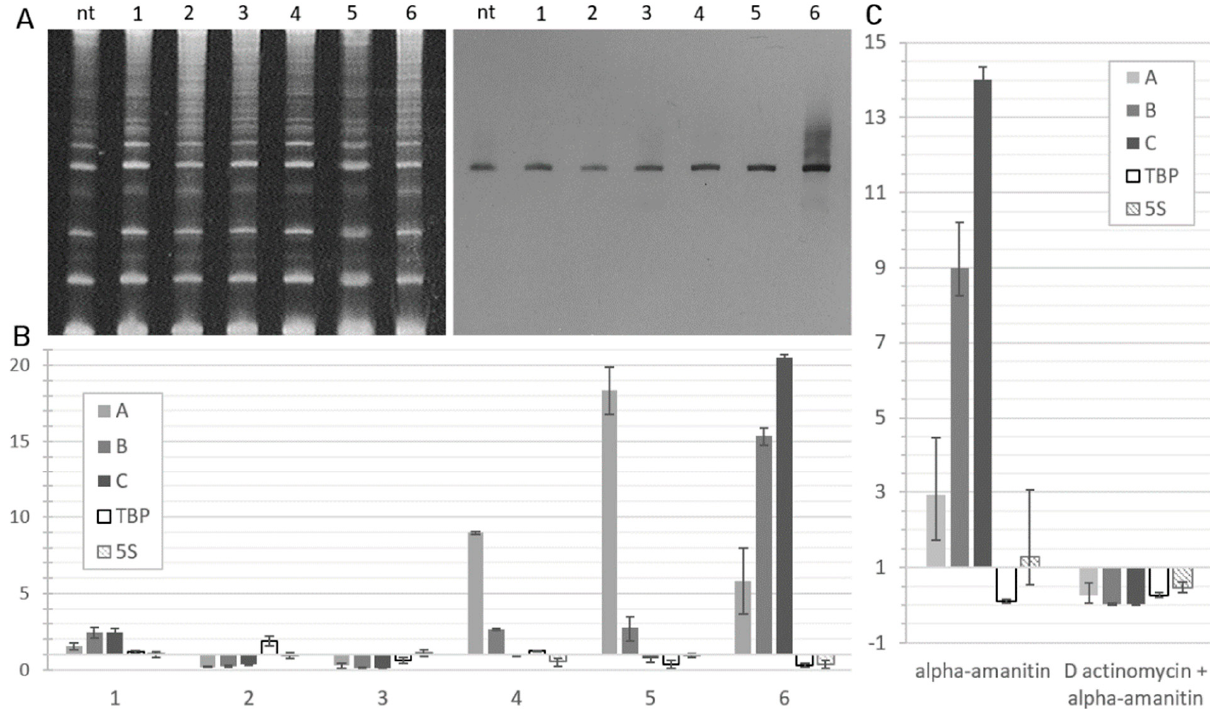
Figure 3. Gene expression analysis of HEK293 cells treated with transcription inhibitors: ML60218 (100 µM) (1) Belinostat (2 µM) (2) D actinomycin (40 ng/mL) (3) doxorubicin (4 µM) (4) BMH-21 (2 µM) (5) and alpha-amanitin (15 µg/mL) (6) compared to non-treated HEK293 cells (nt). ( A ) PAGE and northern-blot of low-molecular RNA fractions from non-treated and treated cells with the ABC sense probe. ( B ) Relative quantity of A, B, and C regions, TBP and 5S in HEK293 cells after the treatment with the indicated transcription inhibitors normalized to 18S and to non-treated cells as reference sample ( ΔΔ C T method). ( C ) Relative quantity of A, B, and C regions, TBP and 5S in HEK293 cells after the treatment with alpha-amanitin (15 µg/mL) and combined alpha-amanitin and D actinomycin (15 µg/mL and 40 ng/mL, correspondingly) normalized to non-treated cells.